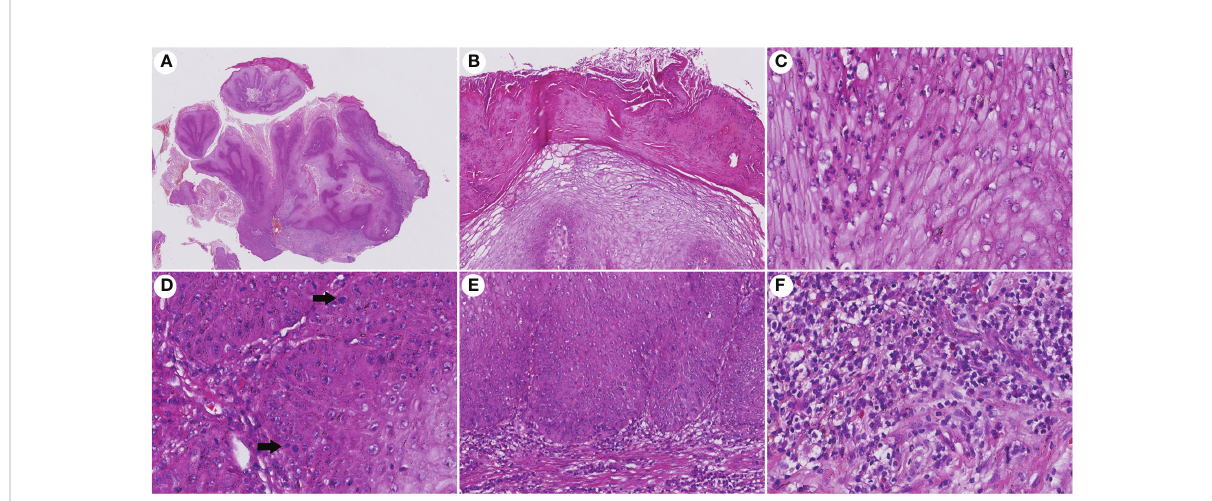
FIGURE 2 Histopathological changes in CVC. (A) Low magni fi cation showed an exo-endophytic growth pattern (H&E, ×10). (B) Exophytic component showed prominent parakeratosis and exudation without koilocytotic cells (H&E, ×100). (C) Intraepithelial microabscesses in severe keratinization tumor cells (H&E, ×400). (D) Basal cell atypia and mitosis (arrow) can be observed (H&E, ×400). (E) Blunted rete ridge with pushing margins (H&E, ×200). (F) Severe dermal in fl ammation of lymphocytes, plasma cells, and eosinophils (H&E, ×400). CVC, cutaneous verrucous carcinoma.